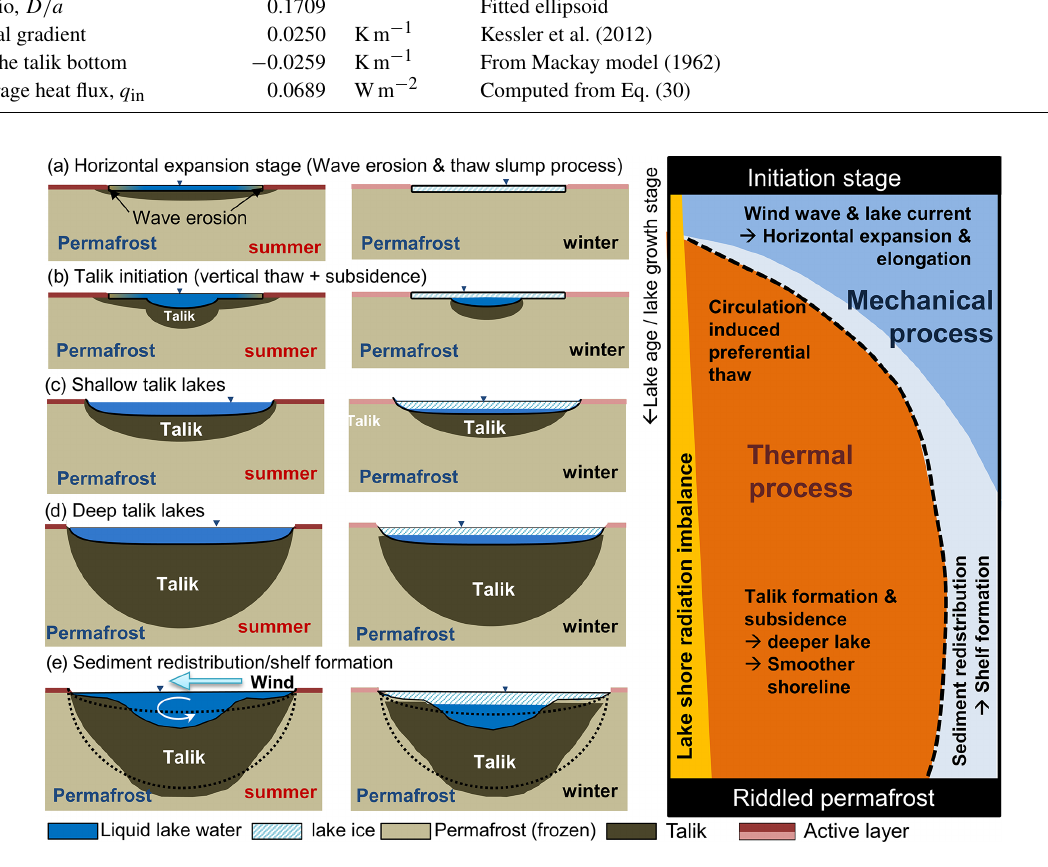
Figure 6. Combined hypothetical models of thermokarst lake evolution and diagram of major influencing factors through time. The left column represents summer conditions, the center column represents winter conditions, and the right column indicates the corresponding importance of mechanical versus thermal processes through time as the lake ages (top is younger, bottom is older). Row (a) indicates the early processes under bedfast ice conditions before talik initiation. Row (b) shows the onset of vertical thaw and subsidence as talik begins to develop. Row (c) shows early, shallow talik growth conditions. Row (d) indicates later-stage processes on deepened talik due to vertical thaw. Row (e) is the mature stage of development when complex bathymetry has set in as a result of sediment